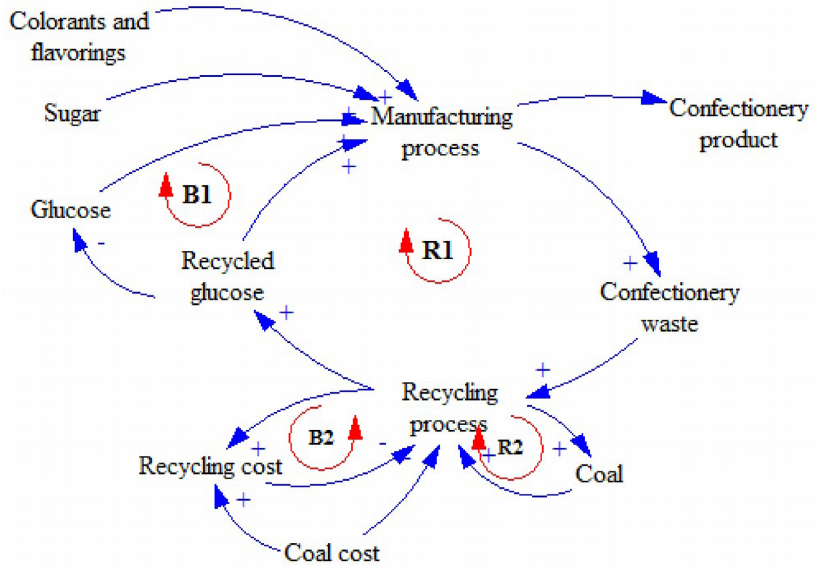
Figure 3. Dynamic behavior of the confectionery case